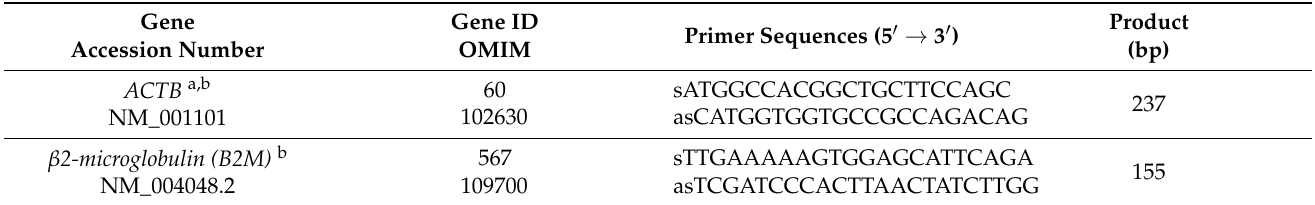
Table 1. Primer pairs used in PCR experiments. a , primers used in RT-PCR analysis. b , primers used in real-time RT-PCR analysis. s, sense. as,